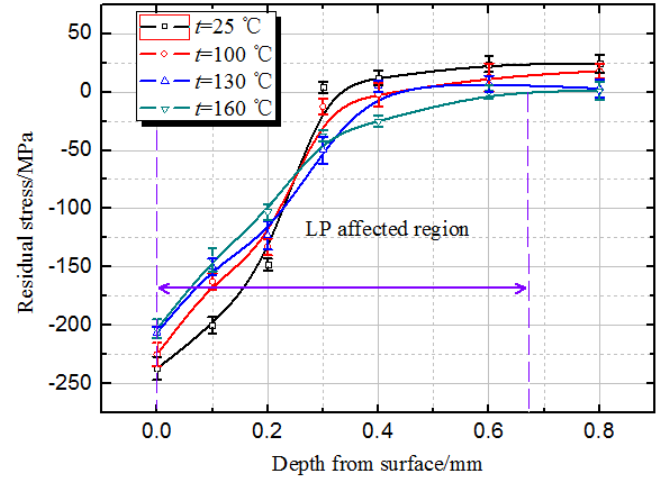
Figure 5. Residual stress distribution in the depth direction at different temperatures.